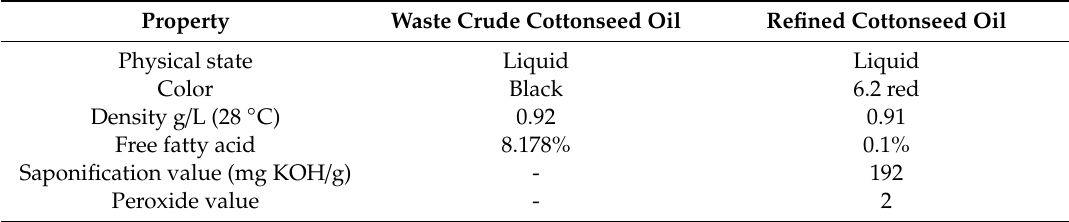
Table 3. Physico–chemical properties of crude and refined waste cottonseed oil. Property